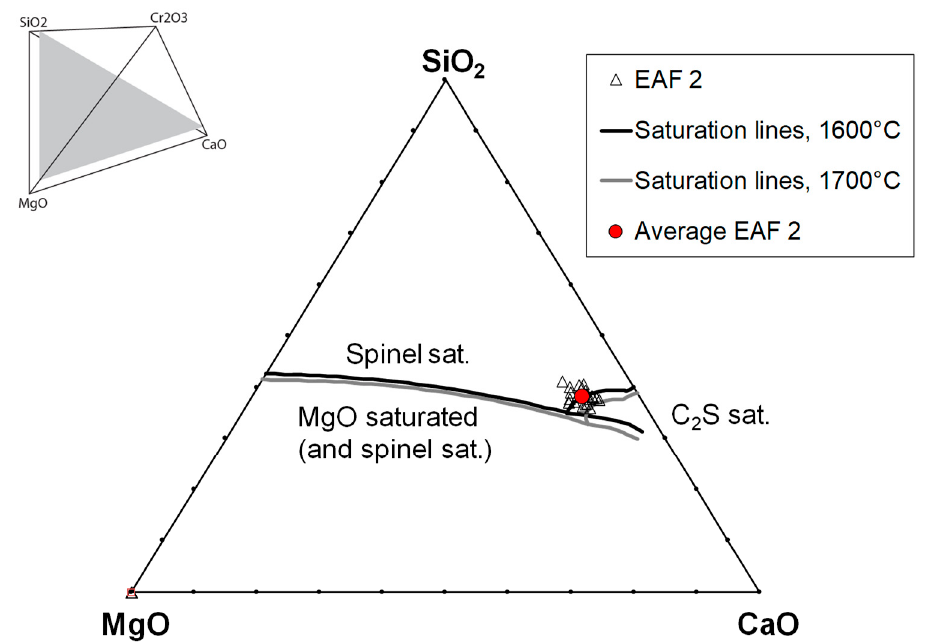
Figure 5. Slag compositions at tapping from EAF 2 versus saturation lines of MgO and C 2 S. Saturation lines are calculated by FactSage (reproduced from [13]) in the system CaO-MgO-SiO 2 -5wt.Al 2 O 3 -3~10wt.Cr 2 O 3 at 1600 °C and 1700 °C (see Figure 3).